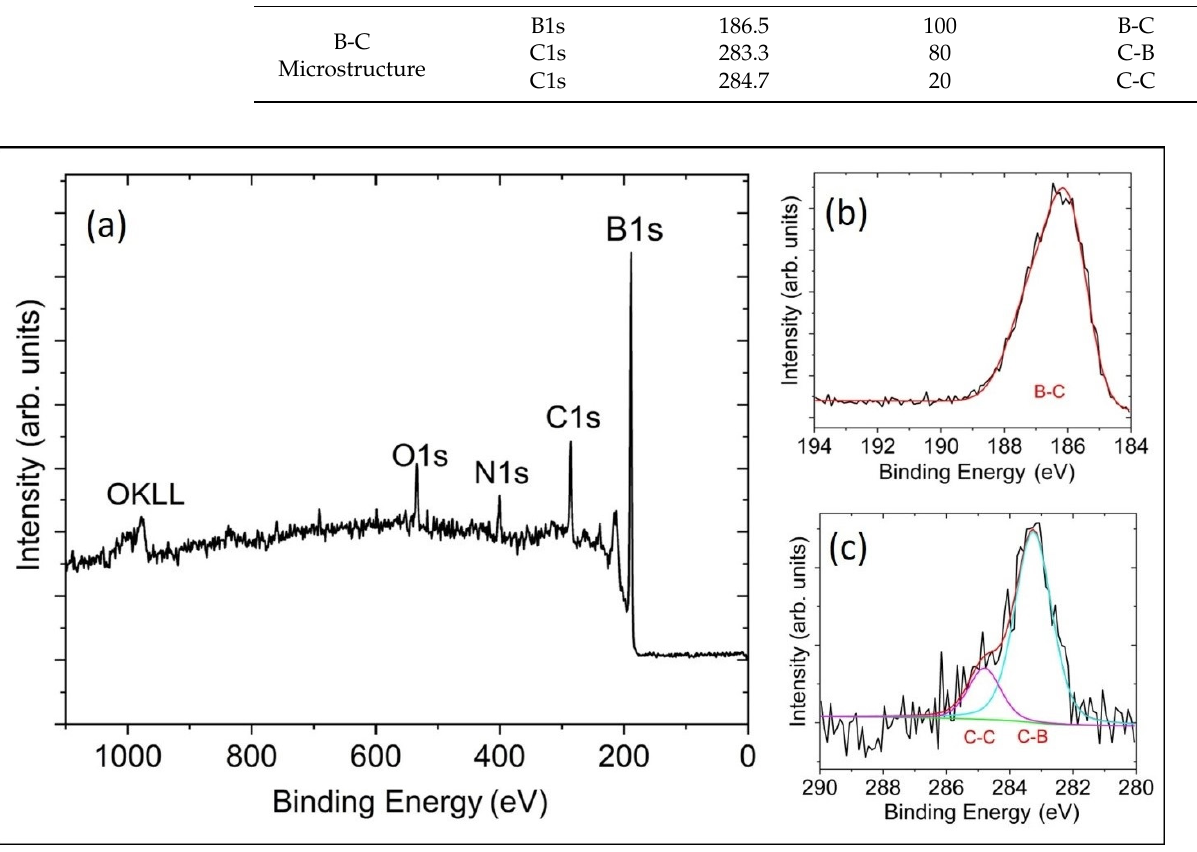
Figure 5. X-ray photoelectron spectroscopy survey scans of ( a ) the B-C microstructure with an elemental composition of 80.6% B, 12.4% C, 3.8% of N and 3.2% O. Panels ( b , c ) show high-resolution scans for B1s and C1s, respectively, with corresponding peaks assigned to B-C, C-B and C-C (adventitious carbon) bonding. Table 1. XPS compositional analysis and fitted parameters of B1s and C1s. [19,20]. Sample Peaks Binding Energy Peak Area (%)